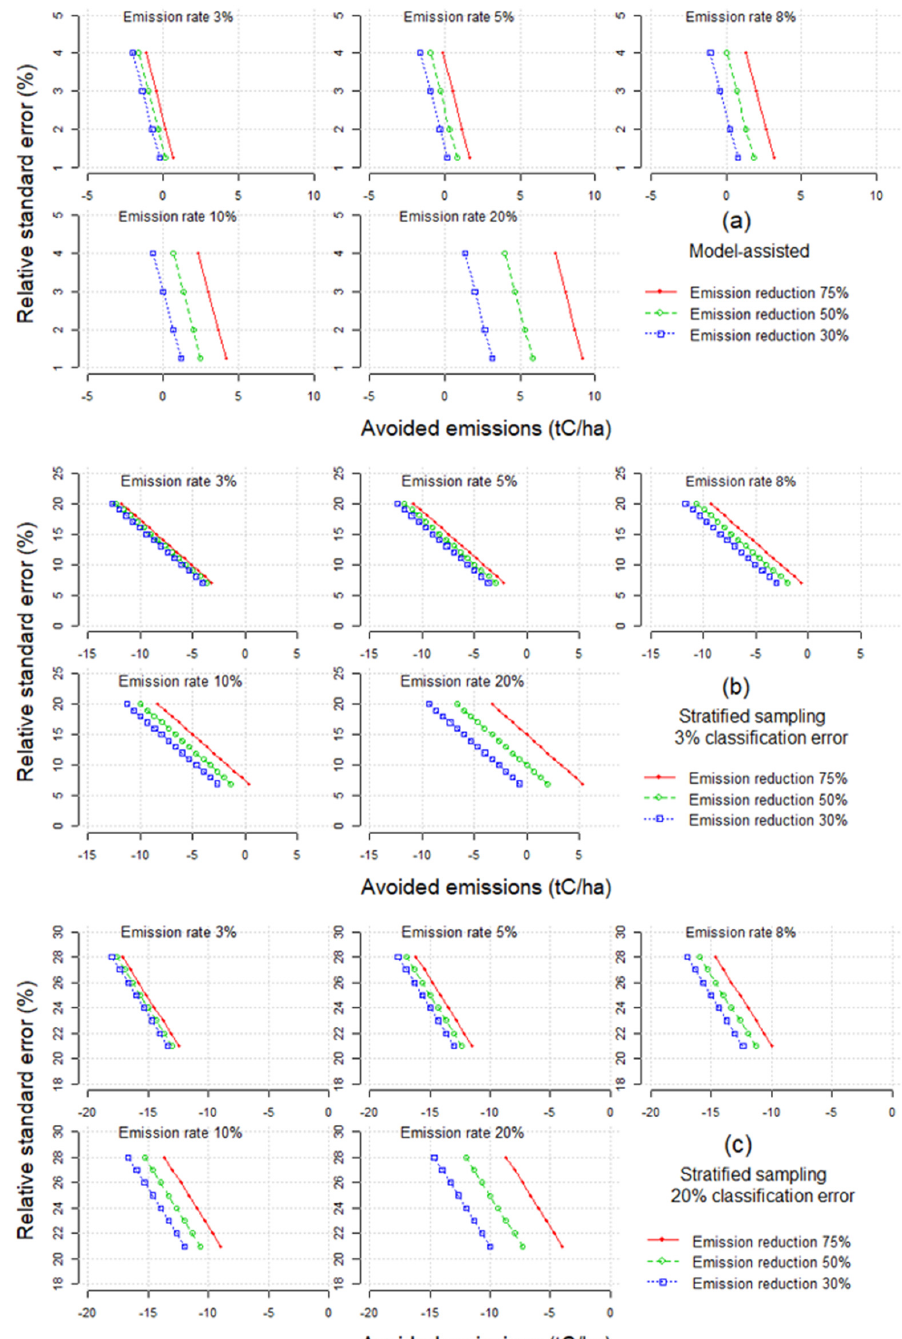
Figure 3. Comparison between the accountable avoided emissions versus the relative standard error achievable adopting three monitoring systems: ( a ) model ‐ assisted approach with Lidar; ( b ) stratified sampling with passive remote sensing considering a 3% classification error; and ( c ) stratified sampling with passive remote sensing considering a 20% classification error. The figure shows the monitoring performances under different baseline emission rates (3%, 5%, 8%, 10% and 20%) and targets of emission reduction (30%, 50% and 75%). The three values of emission reductions are considered as percentage of emission reduction with respect to the reference levels. Negative values of avoided emissions indicate that emissions at t2 (commitment period) are larger than those at t1 (reference period), taking into consideration the principle of RME.